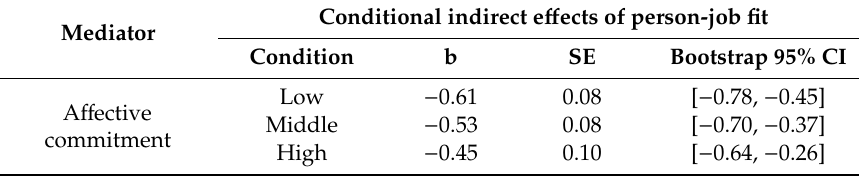
Table 5. Analysis of moderated